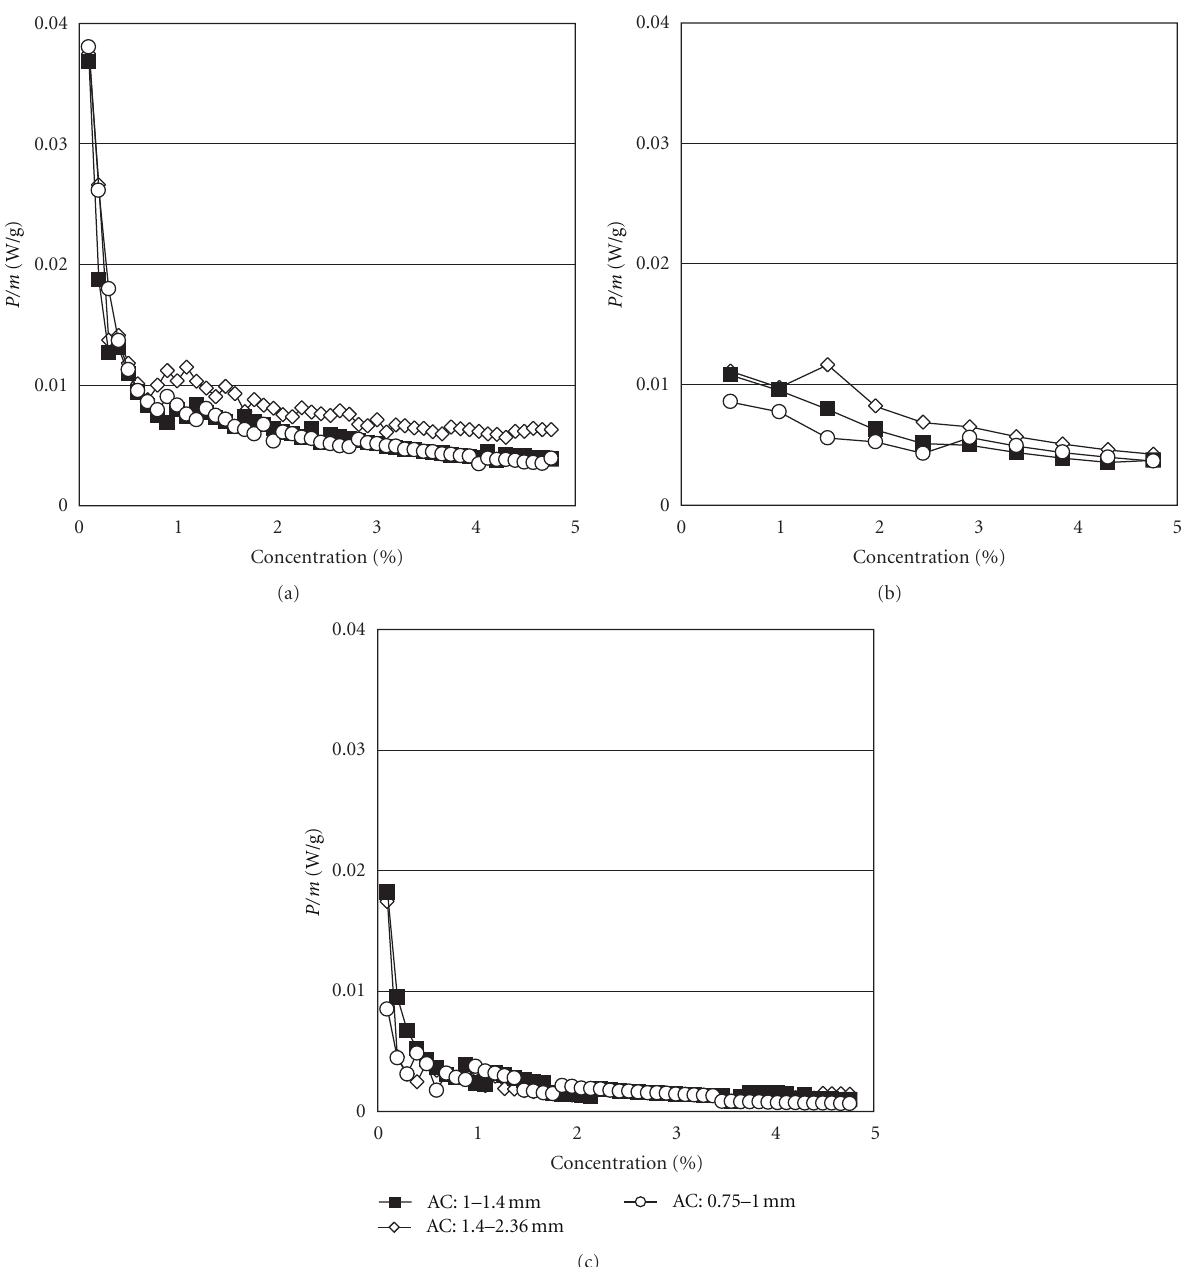
Figure 8: Power per unit solid mass (W/g) versus concentration (%), at varying sizes of activated carbon. (a) 6CB impeller, (b) 6DT impeller, and (c) 6MFD